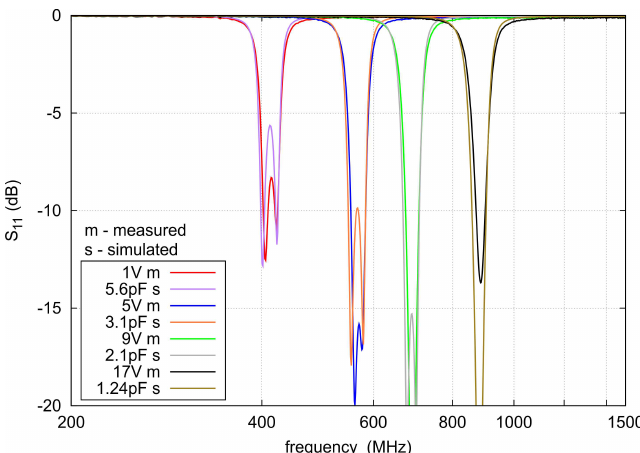
Figure 12. Measured and simulated s 11 of the proposed tunable bandpass filter for the selected control